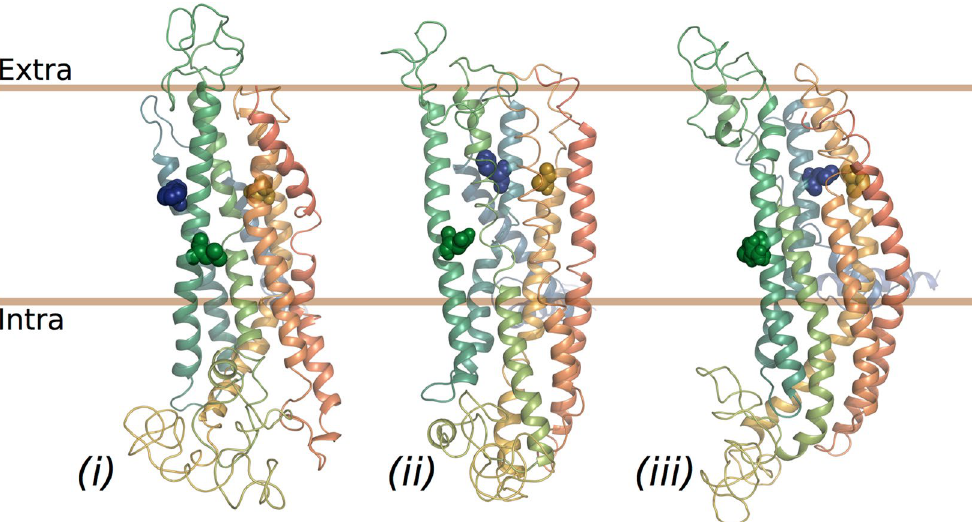
Figure 5. 3D models of Drosophila melanogaster (Dmel) Orco ( i ), Mayetiola destructor (Mdes) Orco ( ii ) and Agrotis segetum (Aseg) Orco ( iii ) based on evolutionary coupling. Residues shown in sphere representation represent residues mutated in this study: blue (DmelOrco F83H, MdesOrco H81F, AsegOrco F83H), green (DmelOrco L135N, MdesOrco N133L, AsegOrco L135N), and gold (DmelOrco A370S, MdesOrco S350A, AsegOrco A356S). Note: protein models are coloured from blue (N-termini) to red